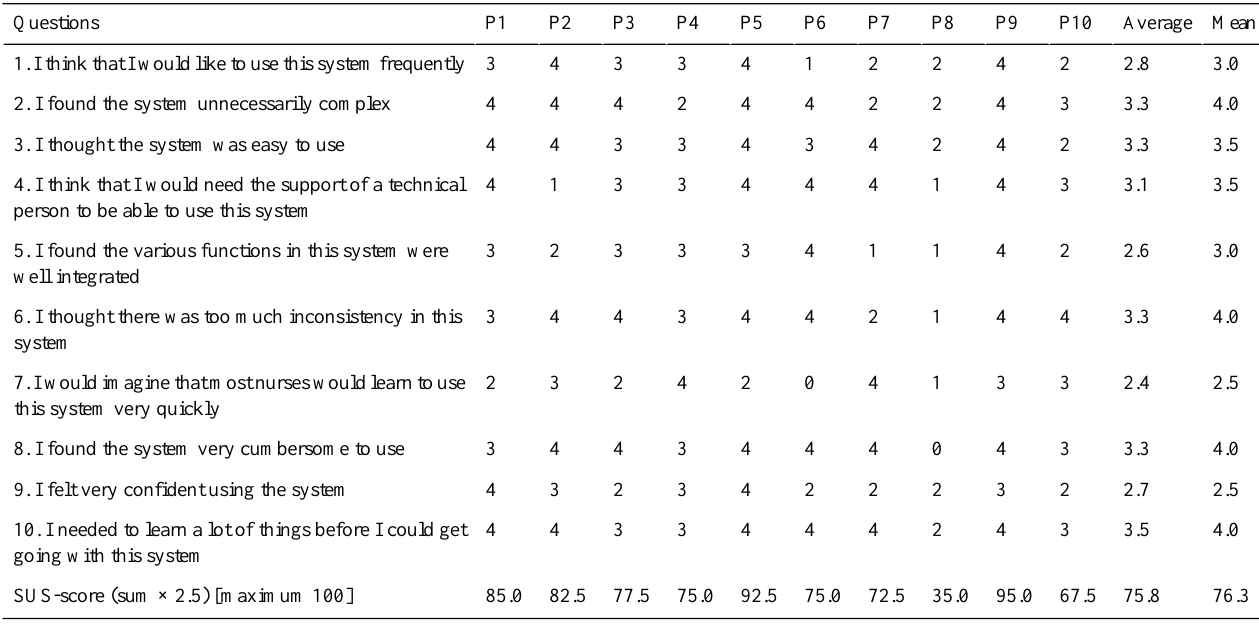
Table 3. Results of System Usability Scale (SUS).